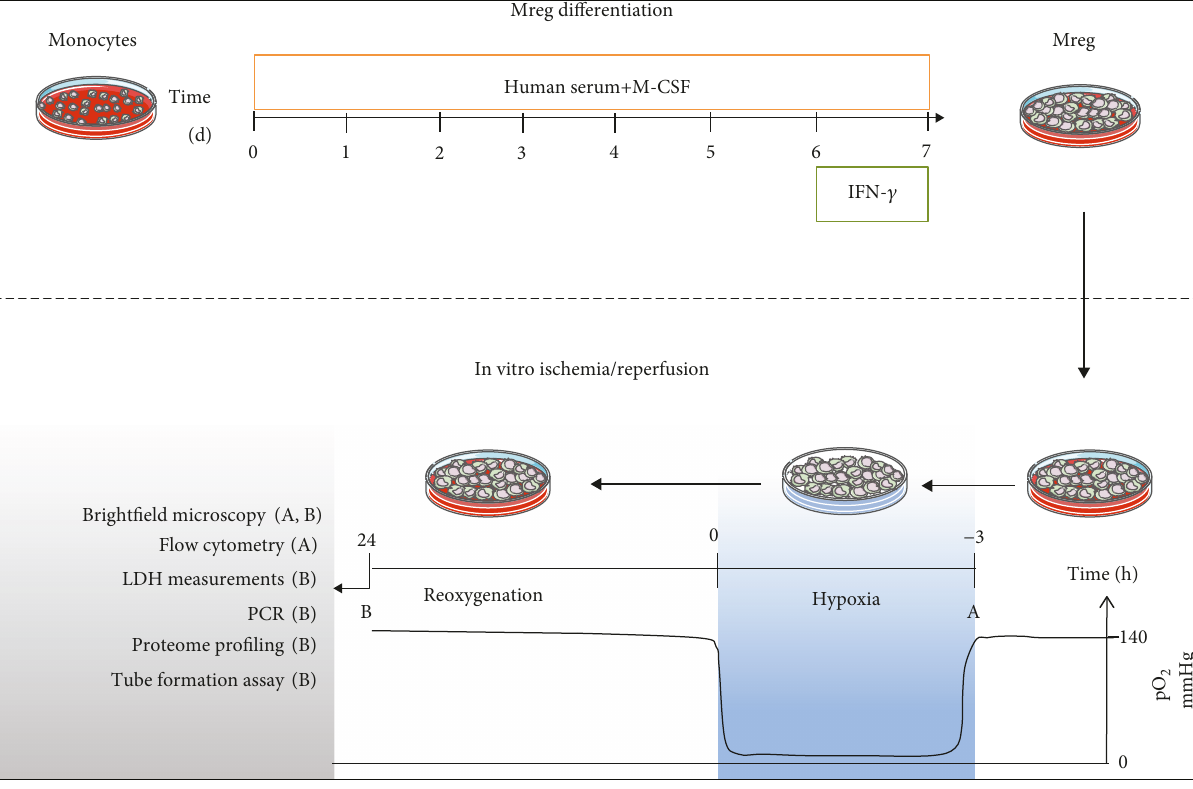
Figure 1: Experimental